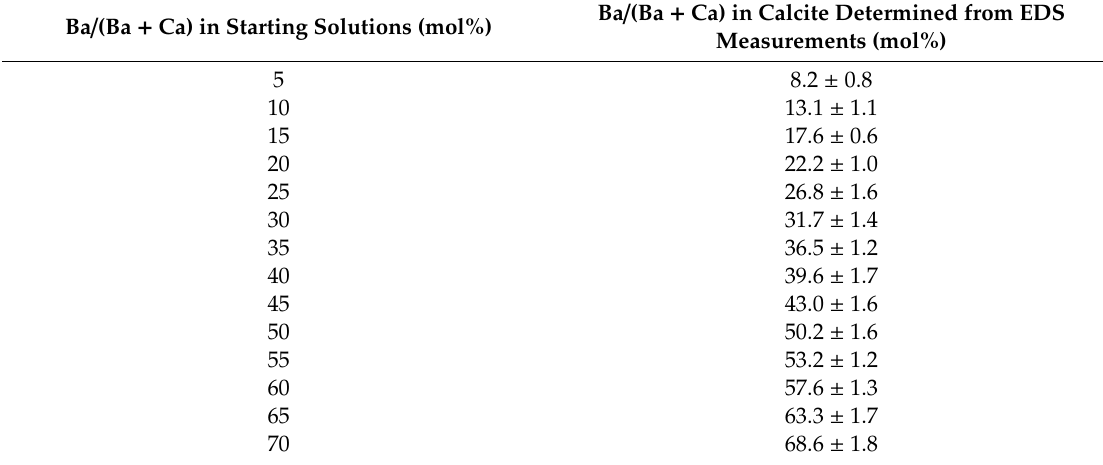
Table 3. Ba / (Ba + Ca) of calcite samples determined from EDS measurements.